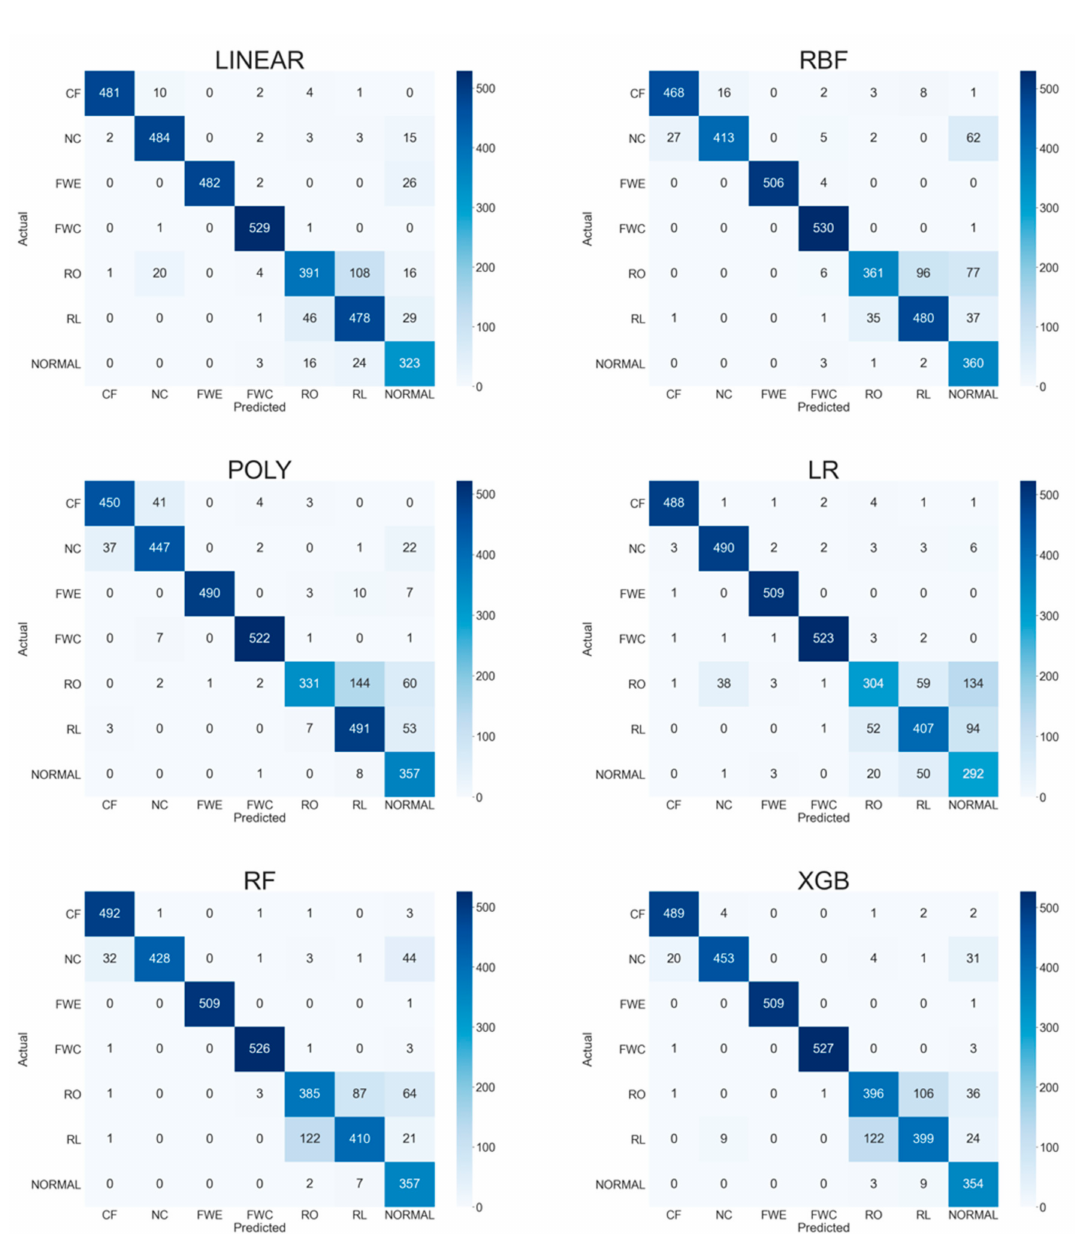
methods. For Linear, the TPR values of CF, NC, FWE, FWC, RO, RL, and NORMAL are 96.59%, 95.09%, 94.51%, 99.62%, 72.41%, 86.28%, and 88.25%, respectively. For LR, the TPR values of CF, NC, FWE, FWC, RO, RL, and NORMAL are 97.99%, 96.27%, 99.8%, 98.49%, 56.3%, 73.47%, and 79.78%, respectively. The TPR values of CF, NC, FWE, and FWC are